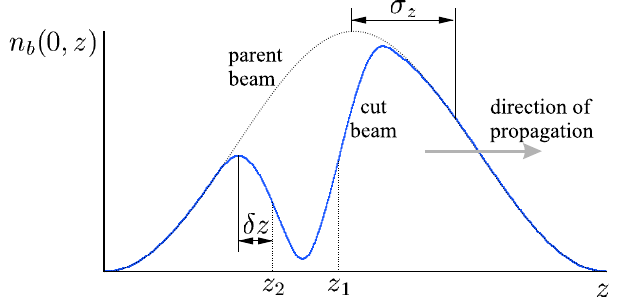
FIG. 1. (Color) Beam shape at the entrance to the